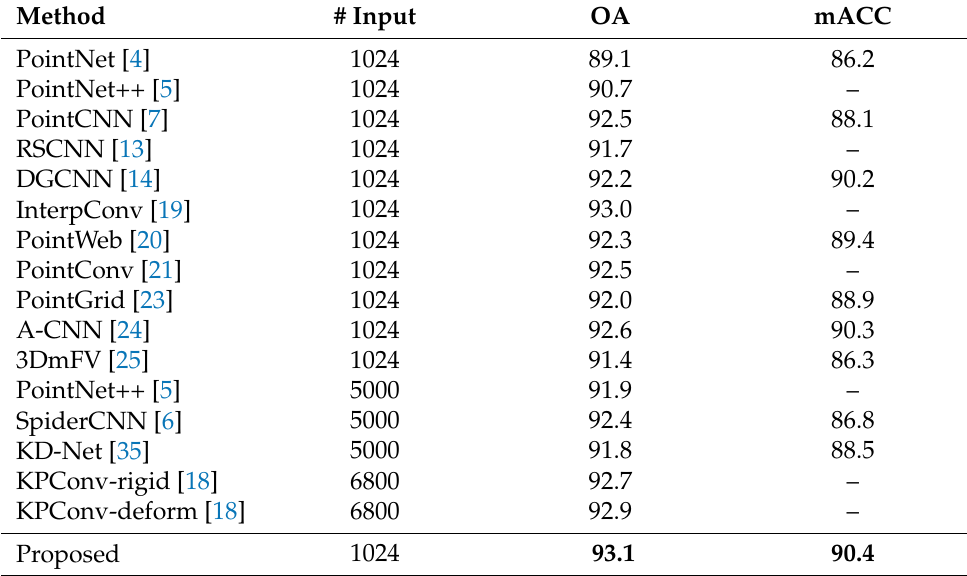
Table 1. Shape classification accuracies on ModelNet40 (OA and mACC in %). Our PSNet with 1024 points achieves the best accuracy even compared with the methods using 5000/6800 points.